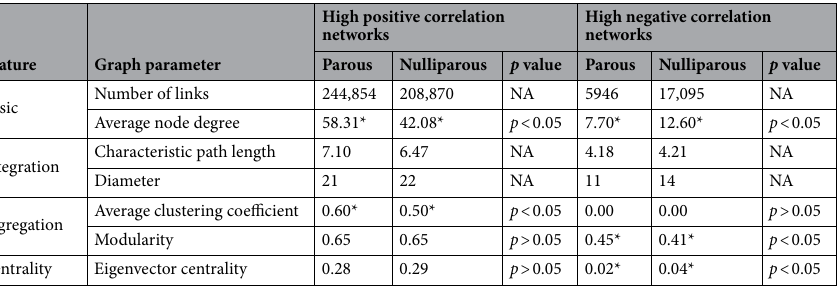
Table 2. Graph-theory parameters associated with the high-correlation networks. Those values of graph characteristics for which significant differences between nulliparous and parous were found have been marked with an